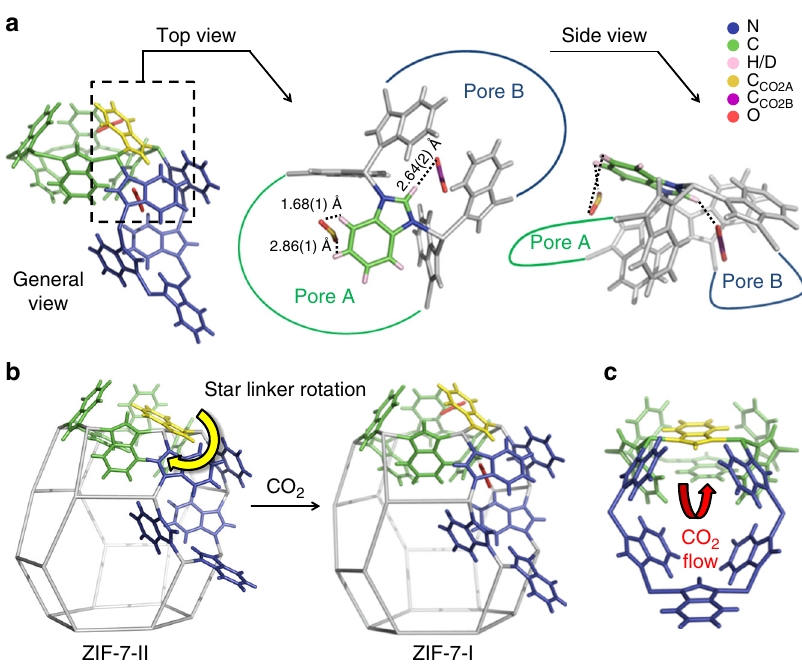
Fig. 3 CO 2 migration route and ZIF-7 structural dynamics. a Spatial relationship between pores A and B as well as adsorbed CO 2 , determined by ND. In general view, pore A: green, pore B: blue, star linker: yellow, CO 2 : red. The symmetry of CO 2 has been disregarded for clarity. In top and side view, star linker: N, blue; C, green; H/D, pink. C of CO 2 in pore A: yellow, C of CO 2 in pore B: purple, O: red. b Star linker rotation caused by CO 2 adsorption in pore B, leading to the ZIF-7-II to ZIF-7-I phase transition. c The channel between pores A and B in ZIF-7-II, allowing CO 2 to migrate from pore B to A. pore A: green, pore B: blue, star linker: